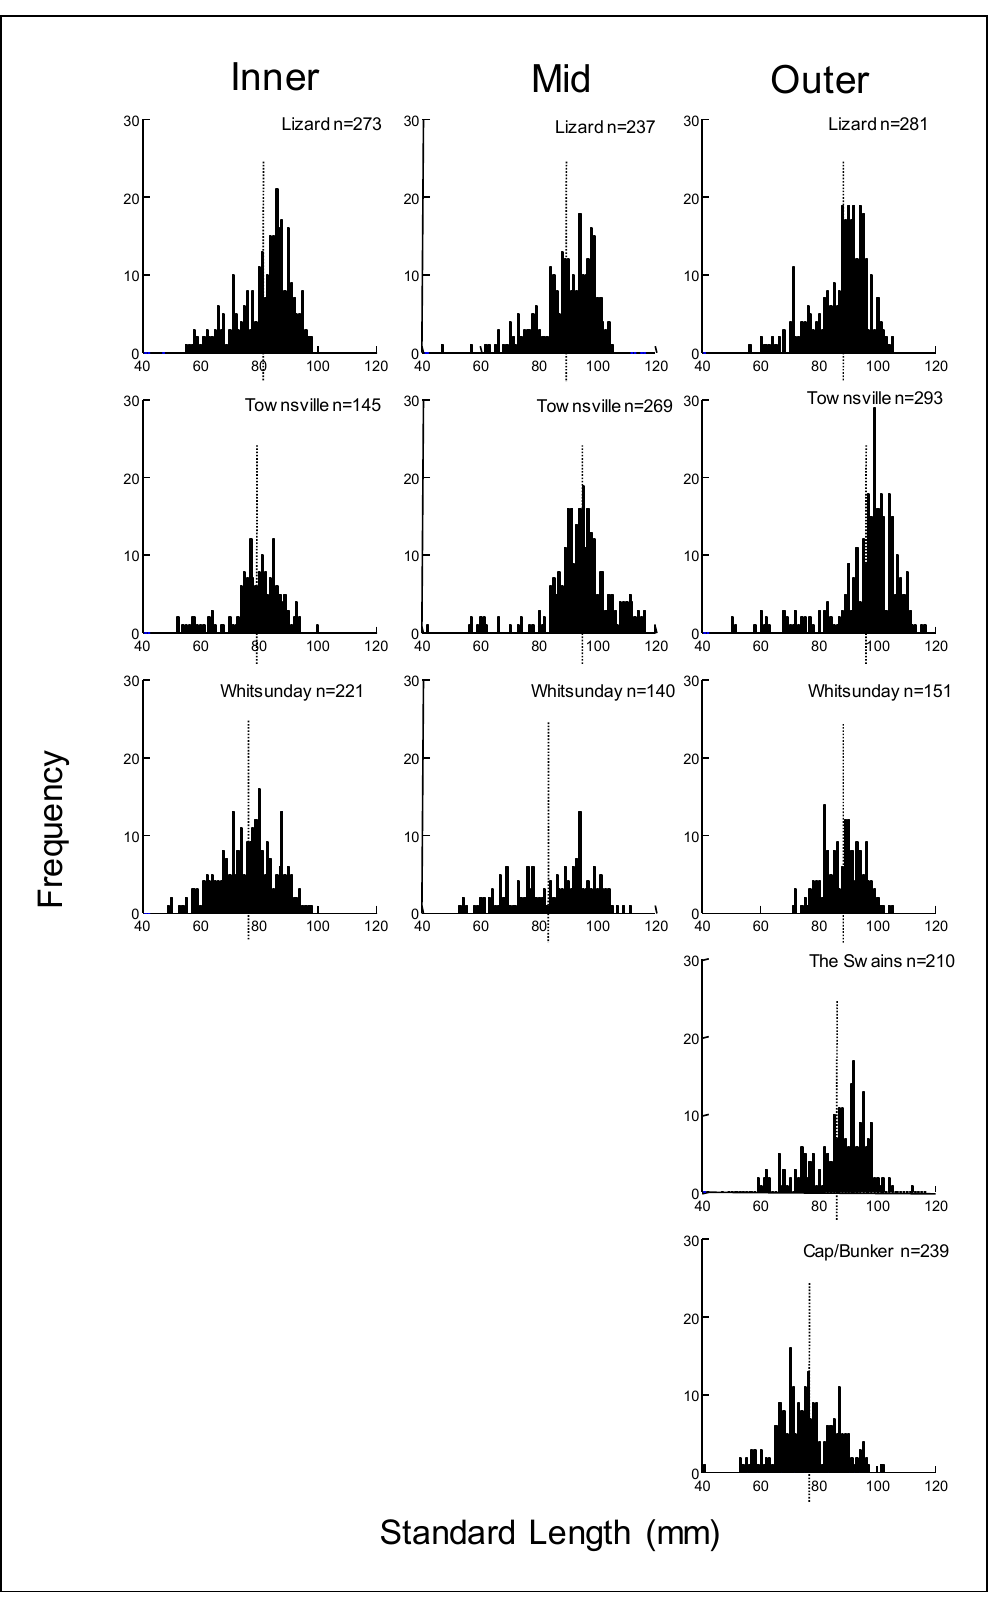
Figure 2. Length–frequency distributions for A. polyacanthus collected from the 11 positions on the GBR (reefs pooled within distances). The mean for each histogram is presented as a dotted